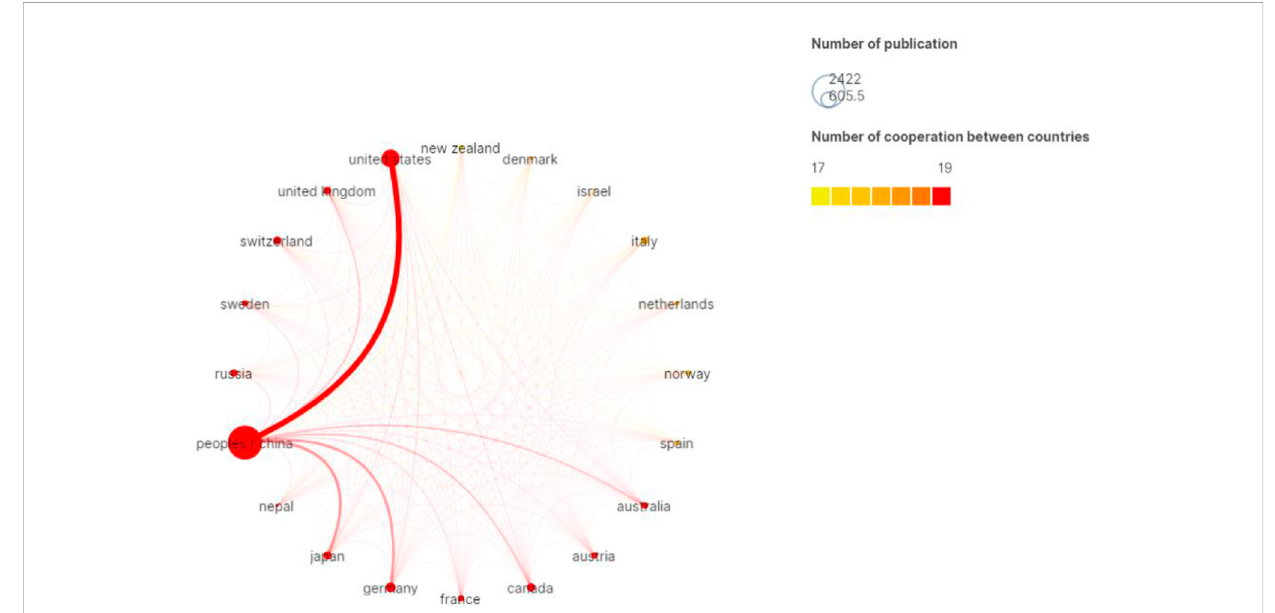
FIGURE 2 Top 20 countries/regions with the largest number of research publications on alpine